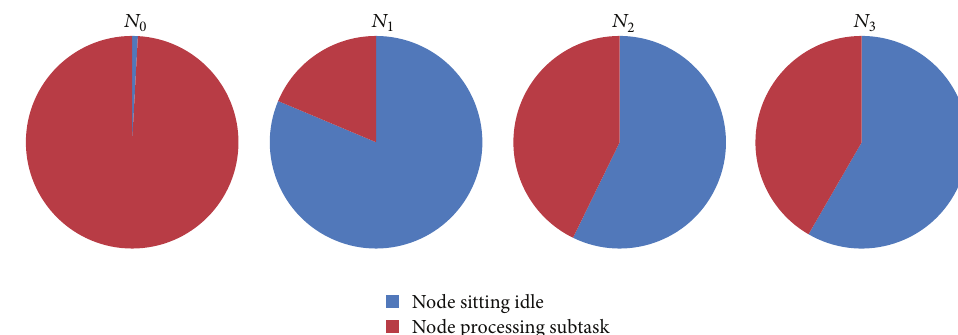
Figure 16: Utilization of P2P nodes in PLBGSA.